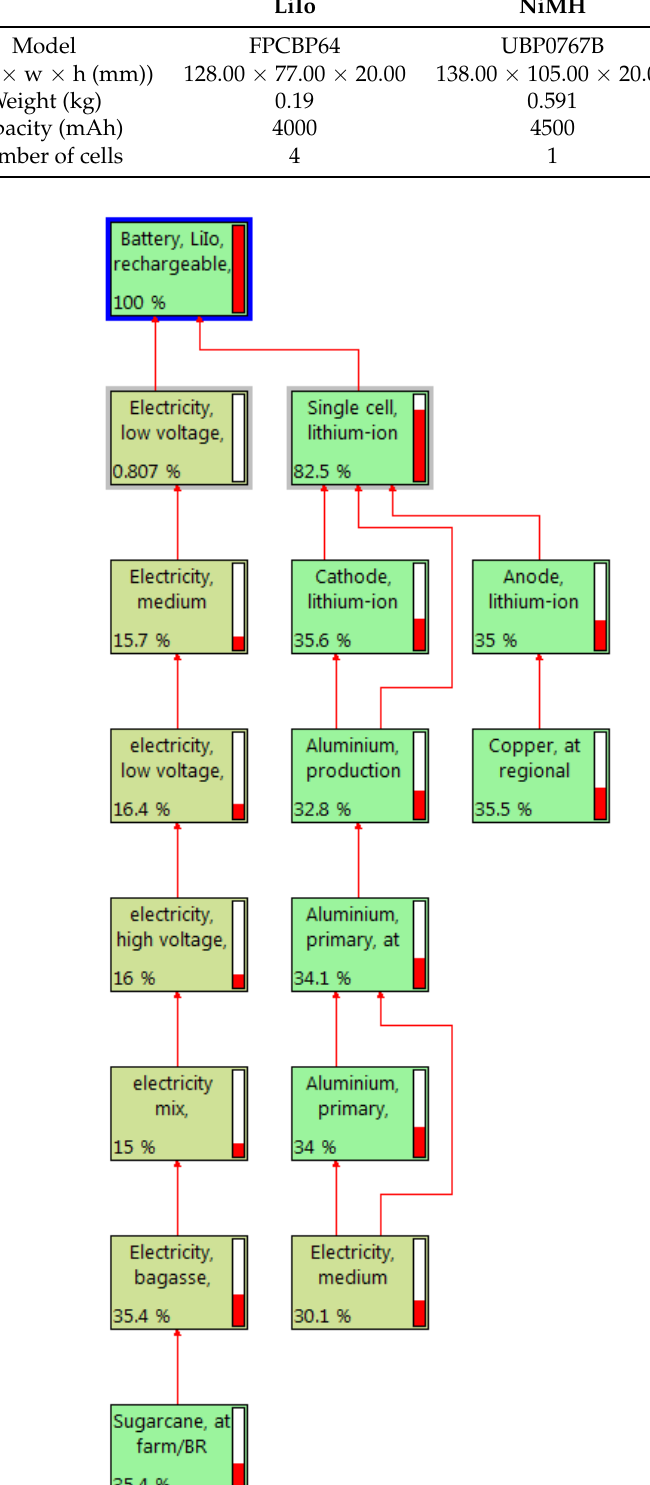
Figure 4. Material flow sheet for 1 kg of LiIo battery